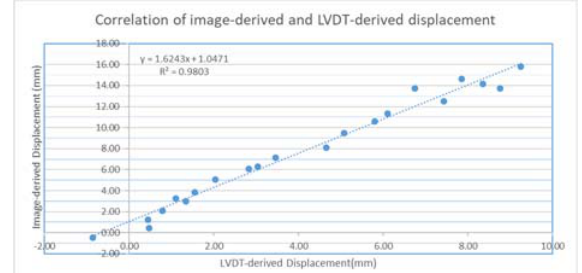
Figure 8. Correlation of image-derived and LVDT-derived